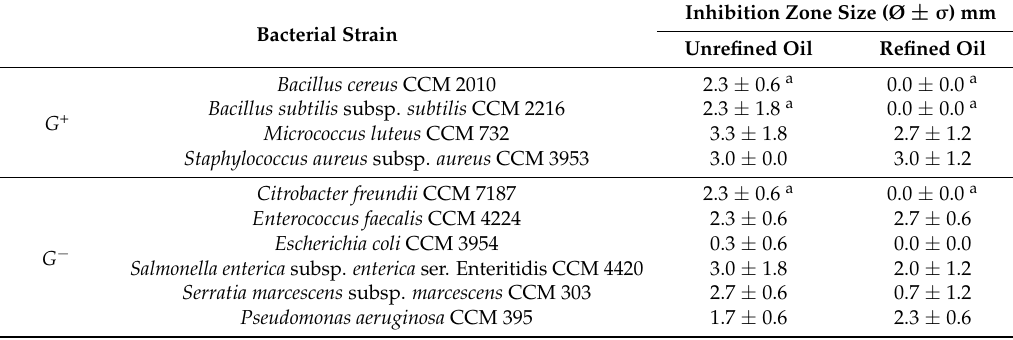
Table 2. Inhibitory effect of hempseed oils (mean ± SD, n = 3 ) against most common pathogenic bacteria, expressed as diameter of the inhibition zone in mm (diameter of the disc was subtracted from the total size of inhibition zone). Means within a line with the same superscript differ significantly ( p ≥